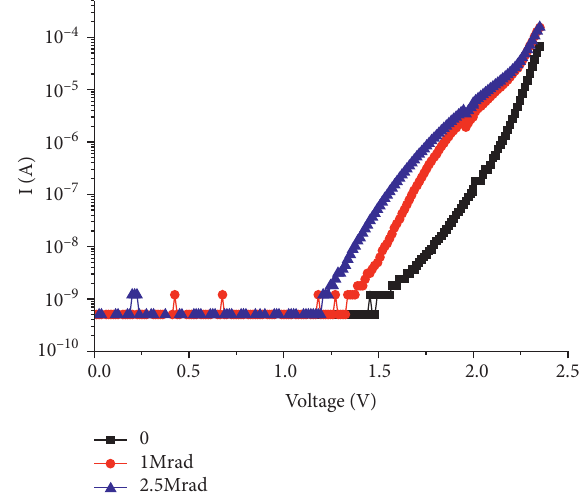
Figure 1: I-U characteristics before and after radiation at low forward bias.